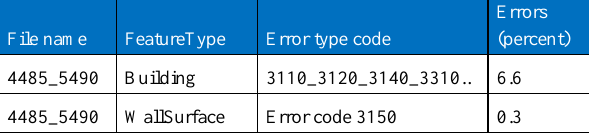
Table 2. Example for an error statistic for a LoD2